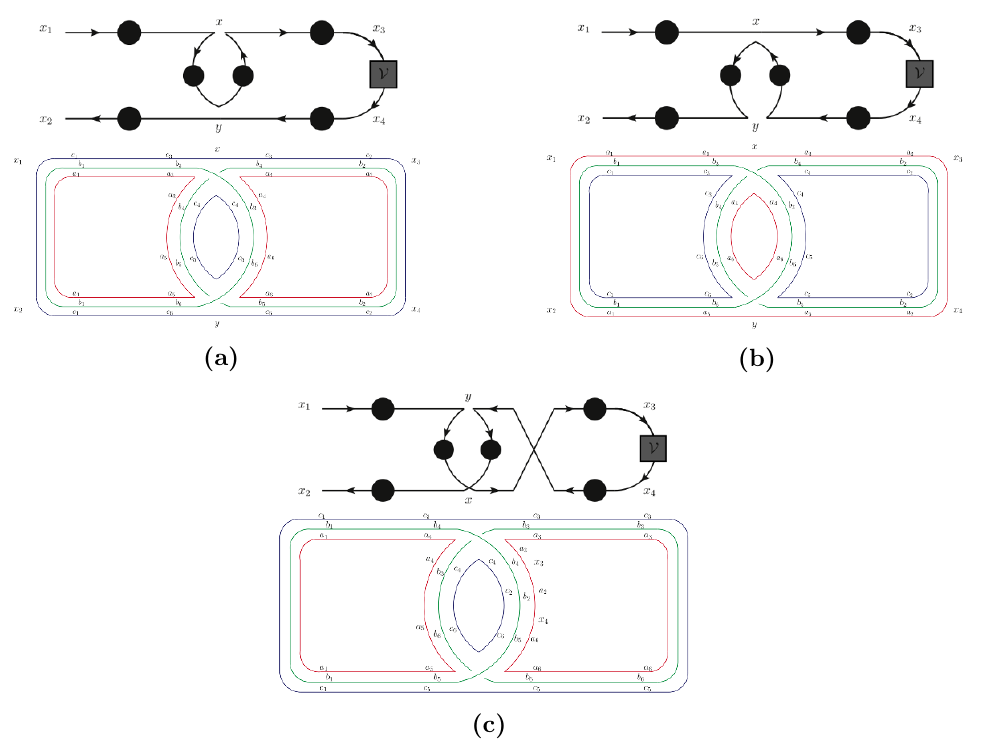
Figure 4. Feynman diagrams corresponding to melonic Wick contractions proportional to (cid:21) 1 (cid:21) 2 . The above diagram shows contraction of spinor indices, and the lower diagram shows contraction of colour